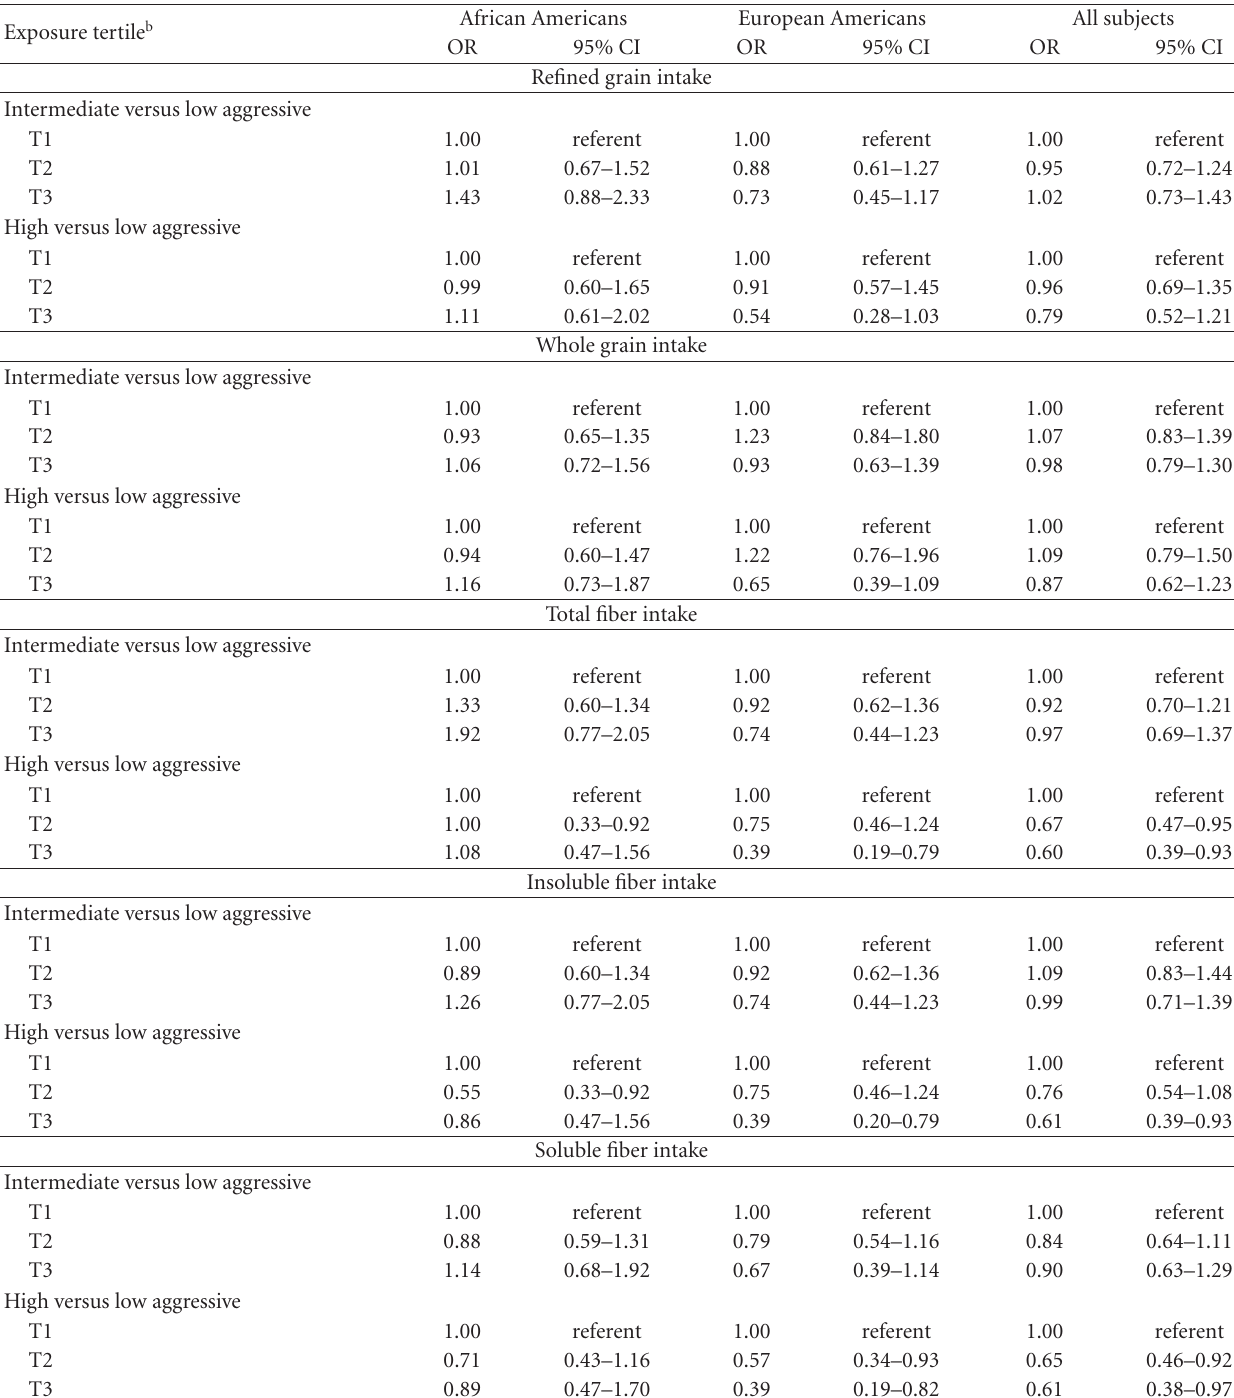
Table 3: Fully adjusted a odds ratios for prostate cancer aggressiveness in relation to refined grain, whole grain, and dietary fiber intake from polytomous regression models, with and without stratification by